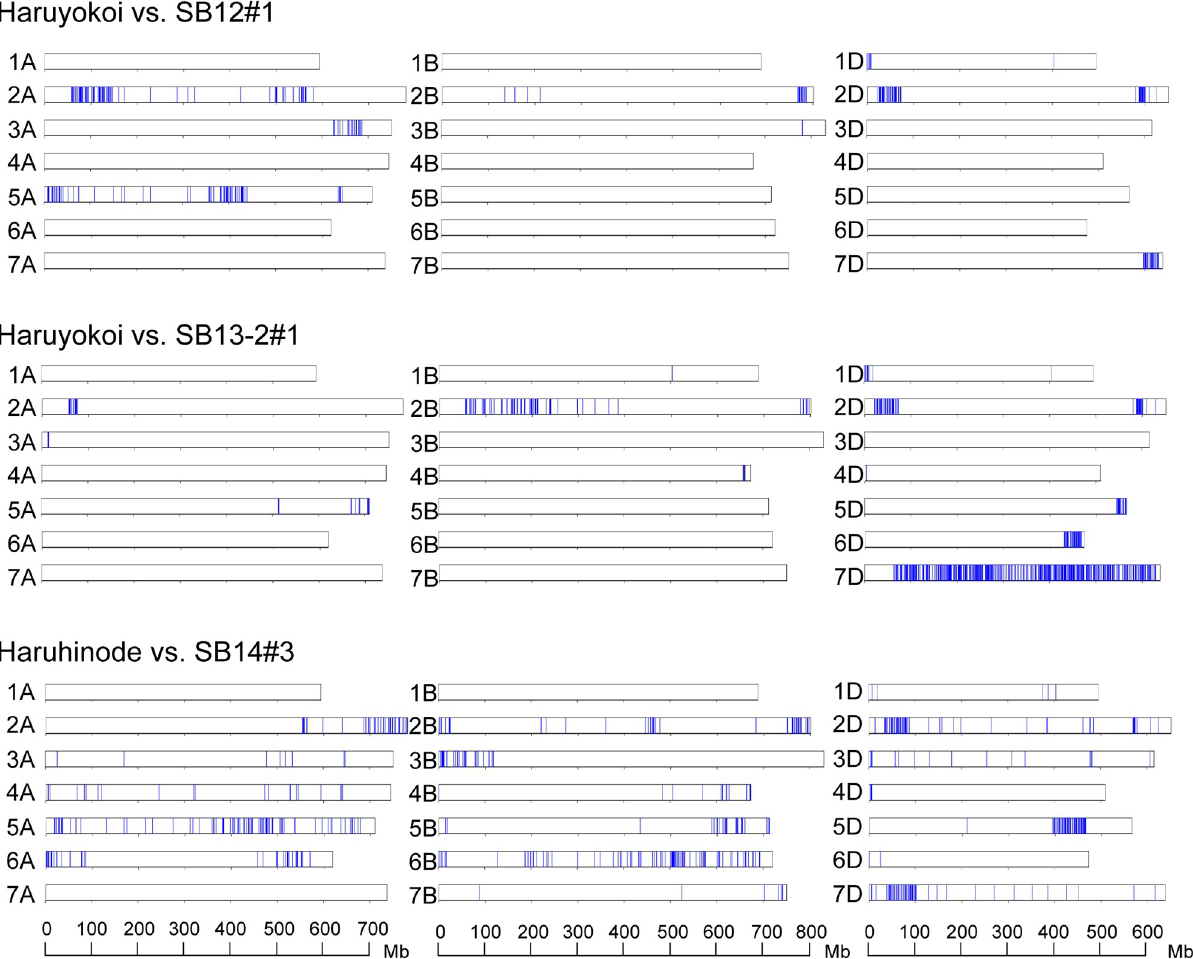
Fig 7. Genome-wide graphical genotypes of the three selected early heading lines of Haruyokoi and Haruhinode. Vertical bars (blue) indicate the SNP sites detected between the two selected lines and their backcrossed parental cultivar Haruyokoi and between the selected line and Haruhinode on each of the 21 wheat